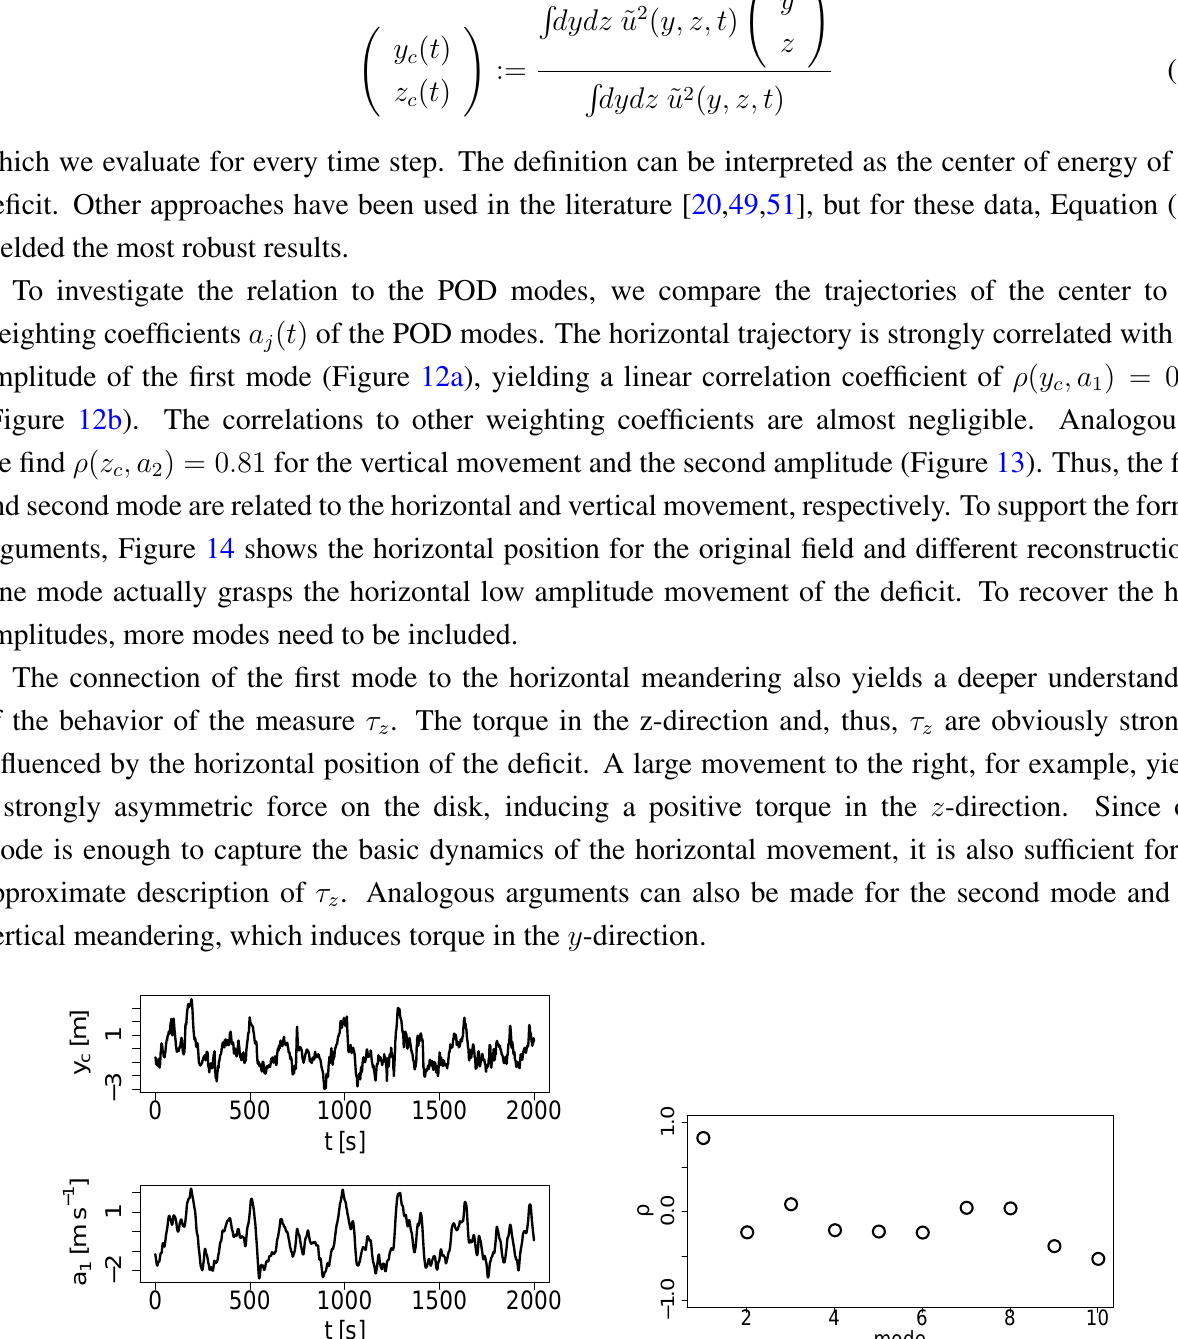
and the horizontal position 1 with the c